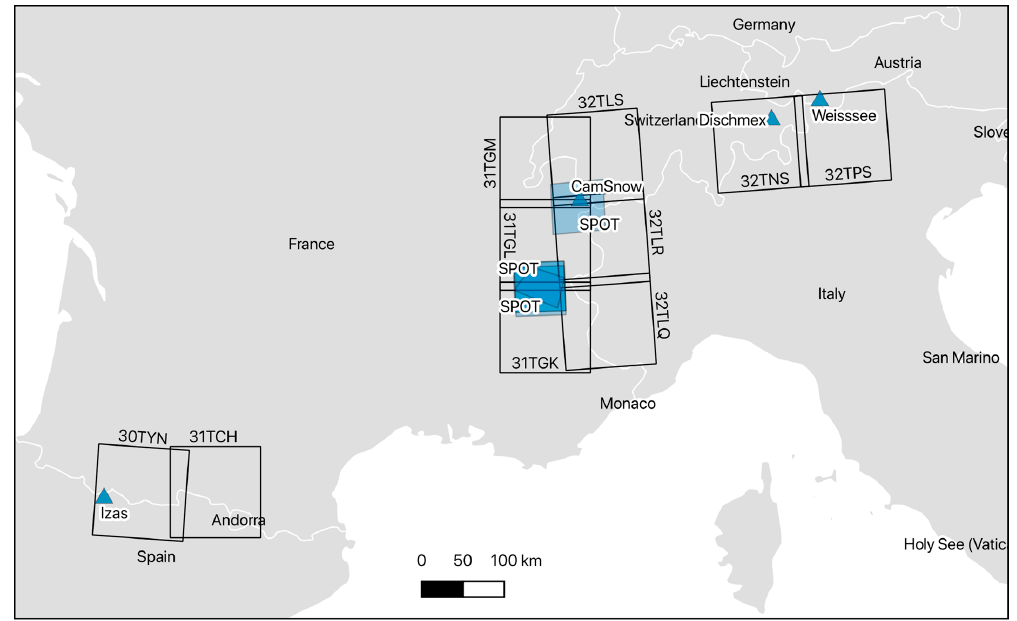
Figure 5. Map of the datasets used for FSC evaluation. More information on the SPOT images is given in